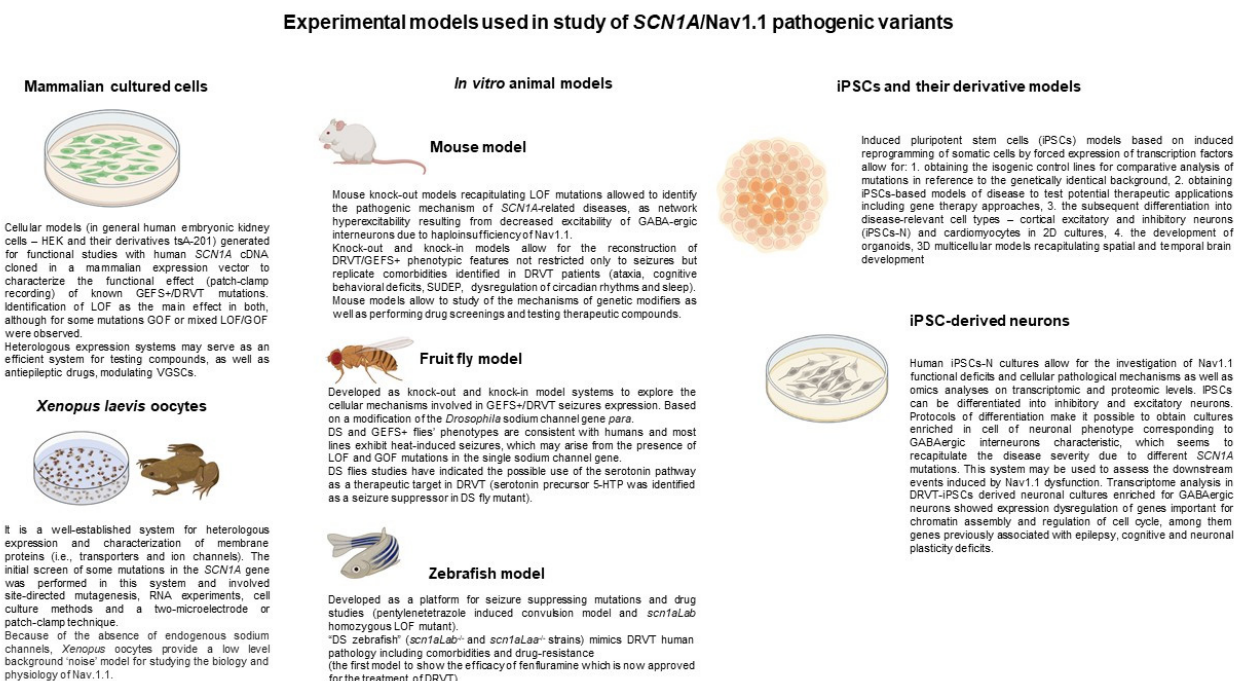
Figure 2. Schematic summary of the experimental models used in research on SCN1A /Nav1.1 pathogenic mechanisms based on Refs [[31,43,45]].